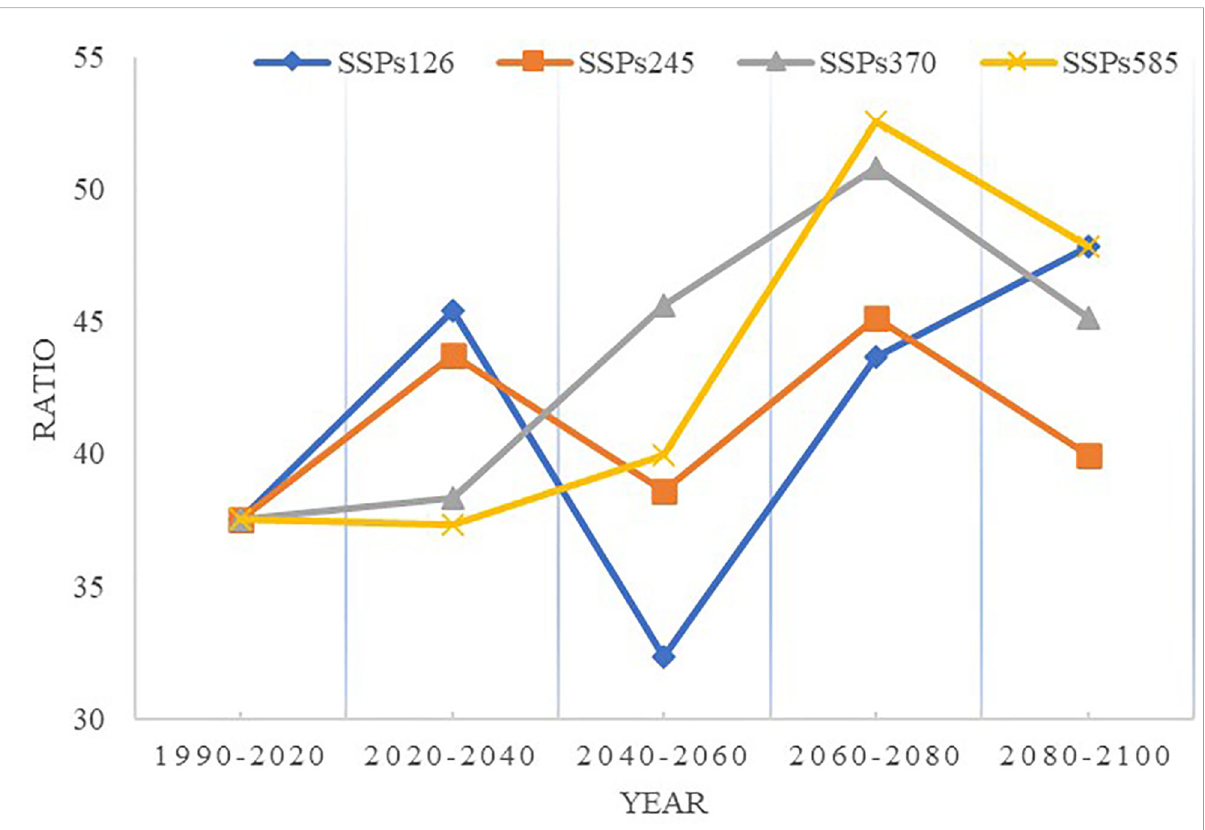
FIGURE 8 Changes in naked oat in the climate suitable area (habitat suitability>0.29) from 2020 to 2100 based on different shared socio-economic